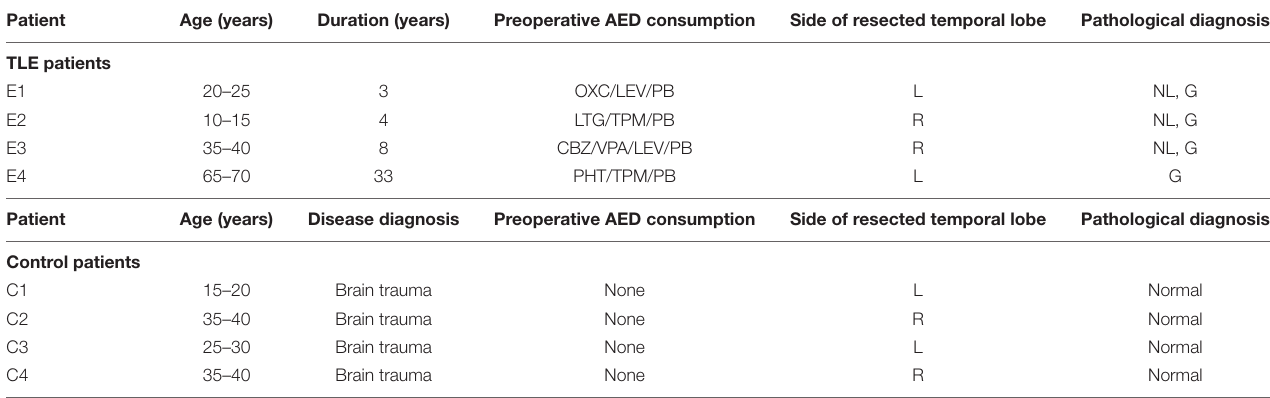
TABLE 2 | The clinical characterization of TLE patients and